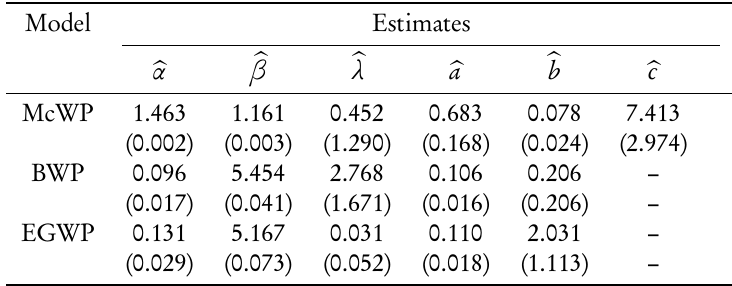
MLEs and their standard errors (in parenthesis) for component failure